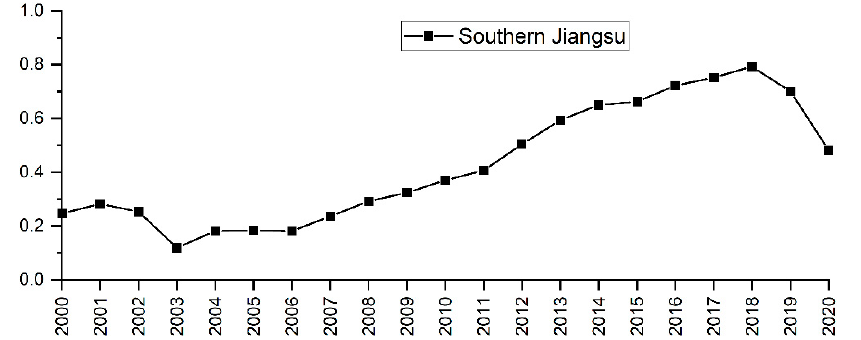
Figure 3. Overall tourism economic development level in southern Jiangsu.